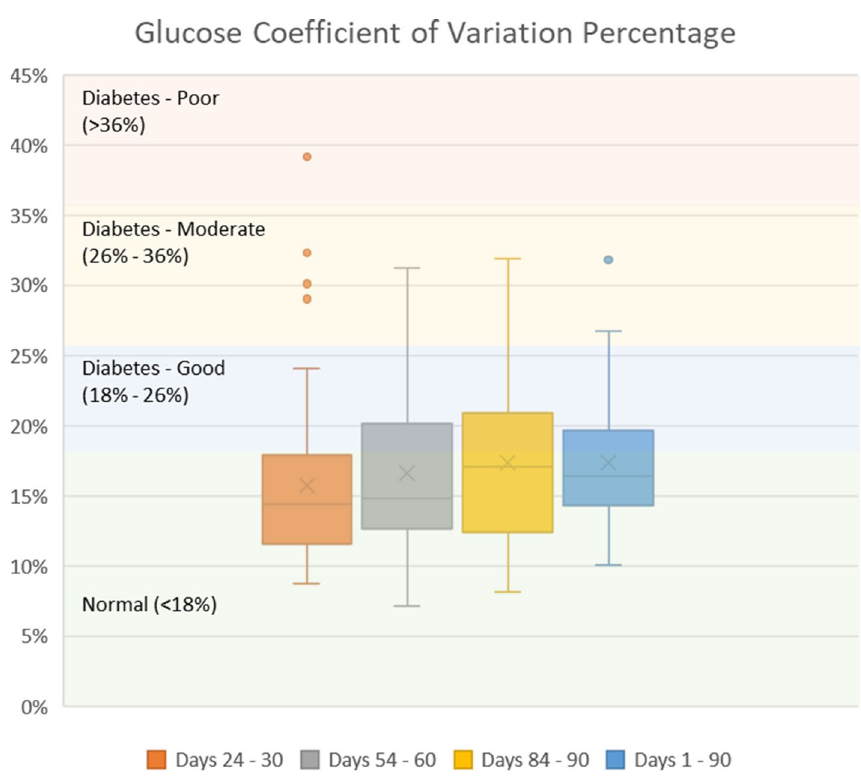
Figure 3. Glucose percent coefficient of variation during the first 90 days of program